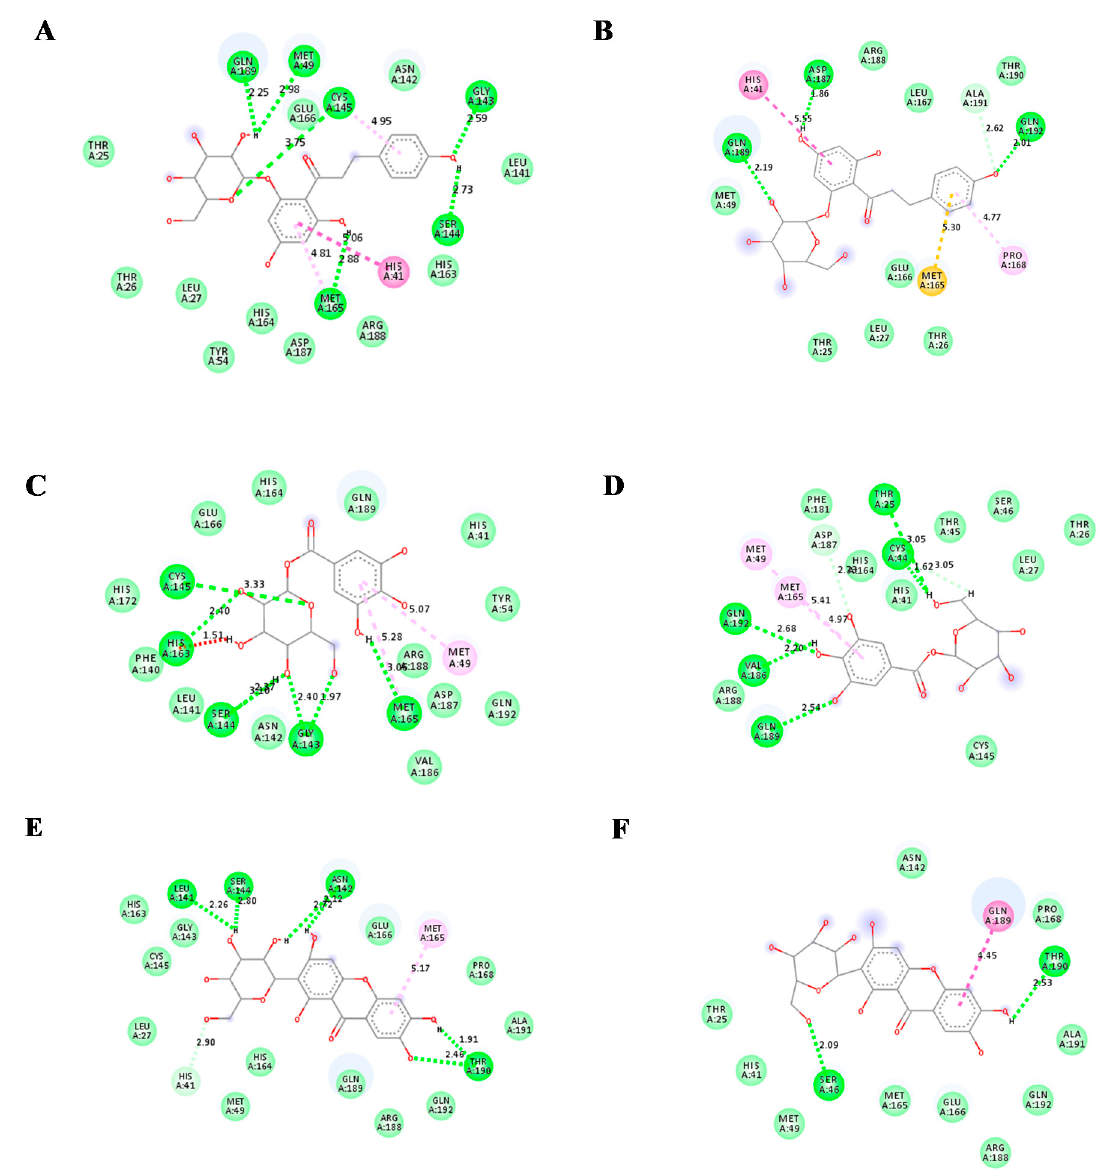
Figure 5. ( A ) Docked phlorizin-Mpro complex (t = 0), ( B ) phlorizin-Mpro complex after MD (t = 10 ns), ( C ) Docked glucogallin-Mpro complex (t = 0), ( D ) glucogallin-Mpro complex after MD (t = 10 ns), ( E ) Docked mangiferin-Mpro complex (t = 0), ( F ) mangiferin-Mpro complex after MD (t = 10 ns).